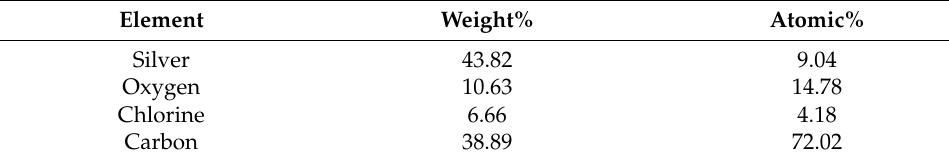
Figure 7. Energy Dispersive X-ray Spectroscopy. ( A ) SEM region of the sample from where the EDS graph was taken. ( B ) The EDS graph, with energy on X-axis and counts on Y-axis, shows the elemental composition of AgNPs in colloidal solution and confirms the presence of AgNPs at the highest spectrum peak of 3 KeV. Table 2. Atomic percent and weight of the elements in